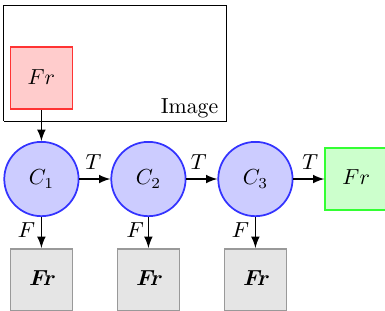
Figure 2. Applying cascade classifiers to the search window on an Figure 1: Kalman filter system model